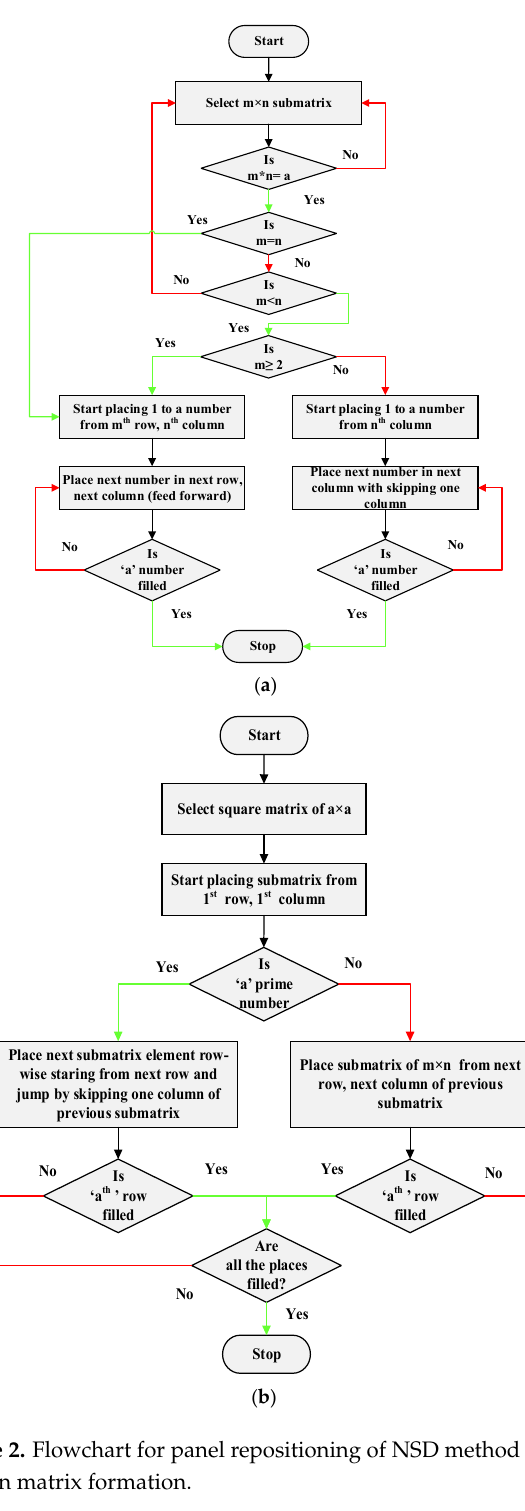
Figure 2. Flowchart for panel repositioning of NSD method ( a ) Step 1: submatrix formation; ( b ) Step 2: main matrix formation.